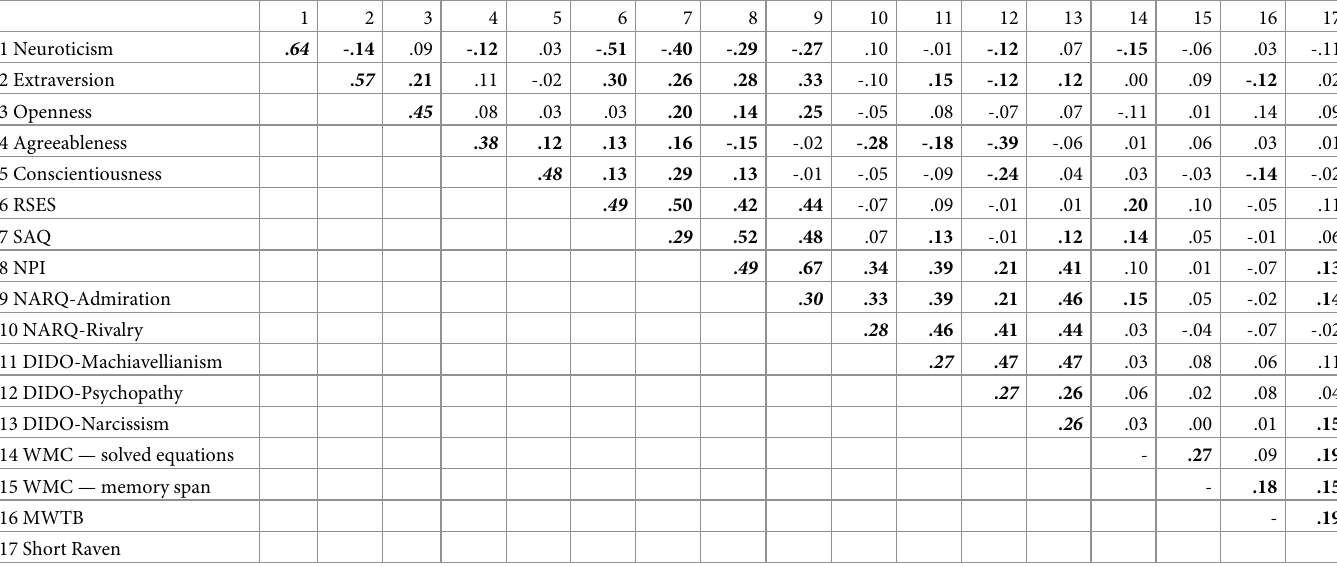
Table 6. PILS selected traits and cognitive abilities.